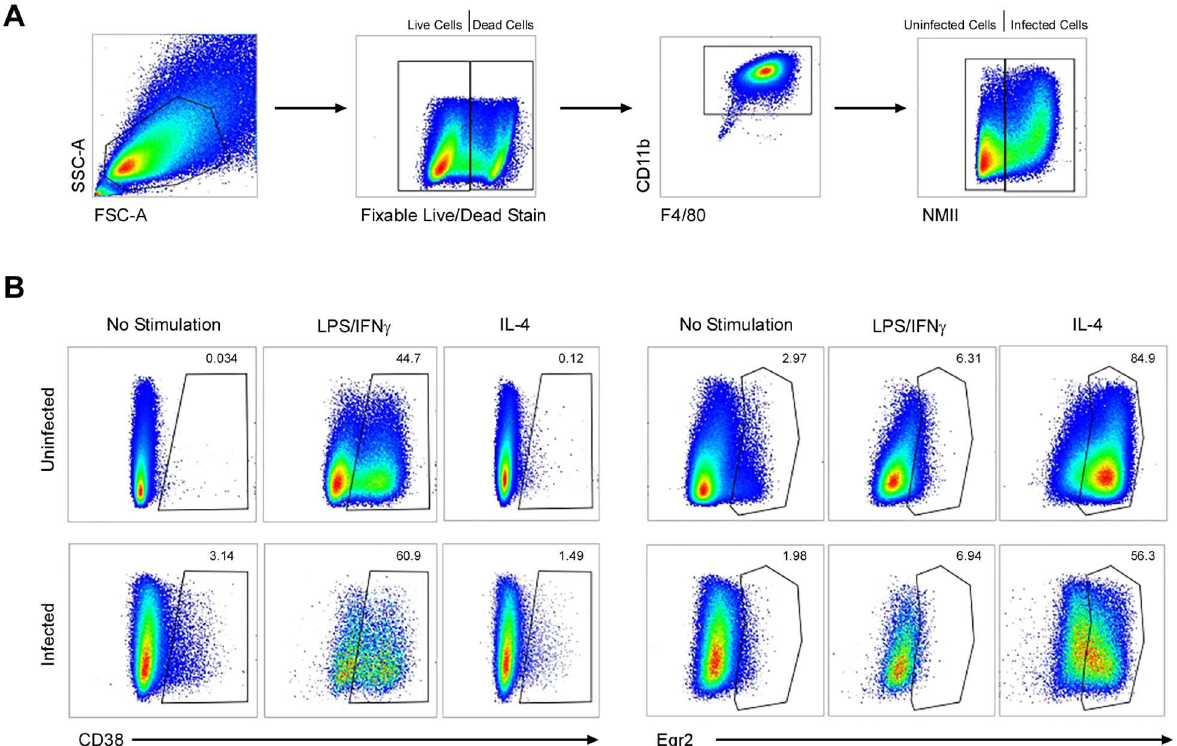
Fig 3. Permissive C57BL/6J BMDM display an M0 phenotype. BMDM were mock infected or infected with NMII at an MOI of 10. At 56 h post-infection, cells were treated with medium (no stimulation), 100 ng/ml LPS, or 20 ng/ml IL4. Six h prior to treatment with LPS, cells were also treated with 20 ng/ml IFN γ . Flow cytometry was conducted at 72 h post-infection. (A) Cells were gated on live CD11b + F4/80 + cells with additionalgating on infected cells basedon NMII signal.(B) Expression of CD38and early growth response protein 2 (Egr2), markers of classically activated (M1) and alternatively activated (M2) macrophages, respectively.Results are representative of three independent experiments.